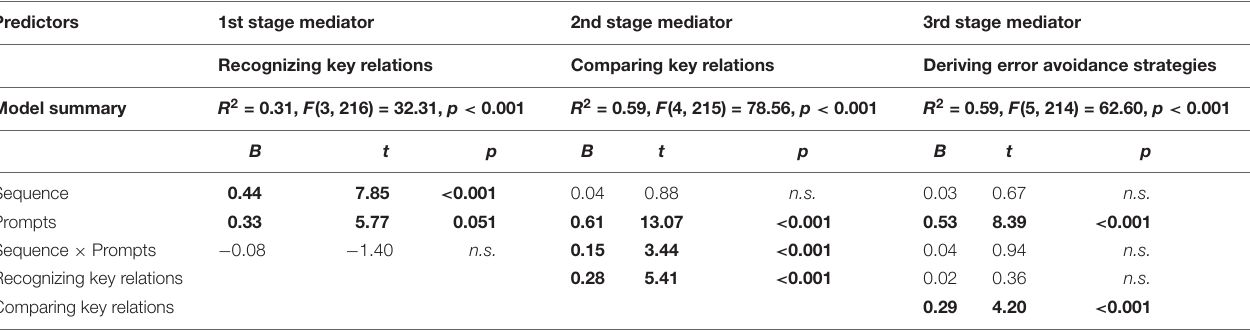
TABLE 5 | Results of moderated serial mediation analyses with the mediators as dependent variables.